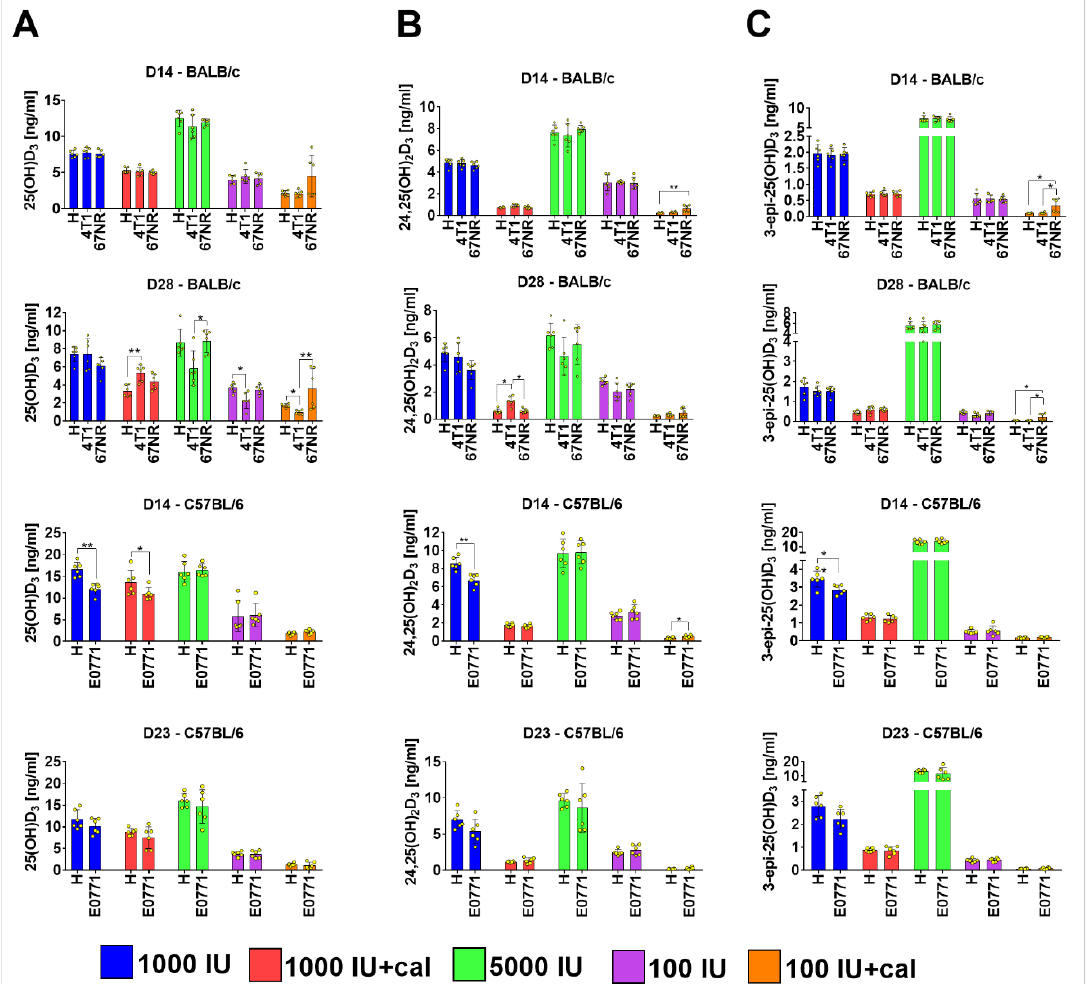
Figure 6. Comparison of vitamin D metabolite plasma level in healthy (H) and mammary gland tumor-bearing BALB/c and C57BL/6 mice. ( A ) 25(OH)D 3 , ( B ) 24,25(OH) 2 D 3 , and ( C ) 3-epi-25(OH)D 3 plasma levels in mice bearing 4T1, 67NR (BALB/c), and E0771 (C57BL/6) mammary gland cancer. Data are presented as mean with standard deviation; individual data are also presented as yellow points. Plasma from 6 mice/group was analyzed. Statistical analysis: Dunn’s test for multiple comparisons or Mann–Whitney test. * p < 0.05; ** p < 0.01.